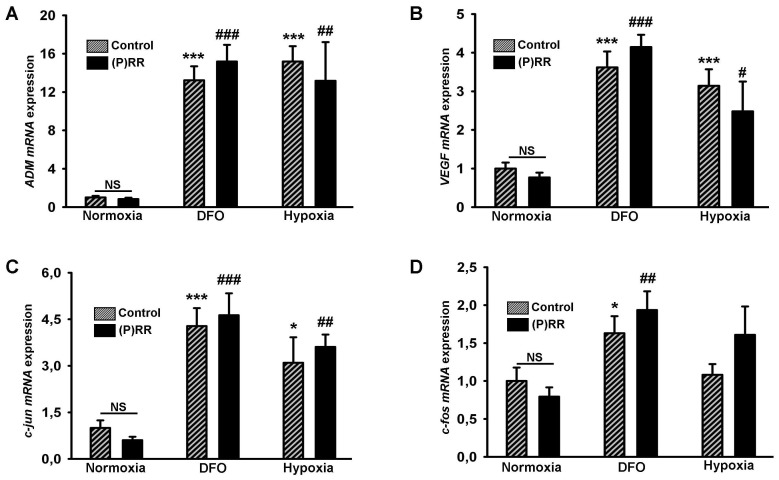
Effect of (P)RR overexpression on stress related gene expression due to hypoxia.Gene expression levels in HeLa cells under normoxia, DFO (deferoxamine) treatment and hypoxia; HeLa cells without (fine bars) and with (black bars) (P)RR overexpression. A) ADM B) VEGF C) c-jun D) c-fos (all normalized to GAPDH). *P<0.05, ***P<0.001, normoxia vs. DFO or normoxia vs. hypoxia, under control condition. #
P<0.05,
##
P<0.01 and ###
P<0.001, normoxia vs. DFO or normoxia vs. hypoxia, under (P)RR overexpression.